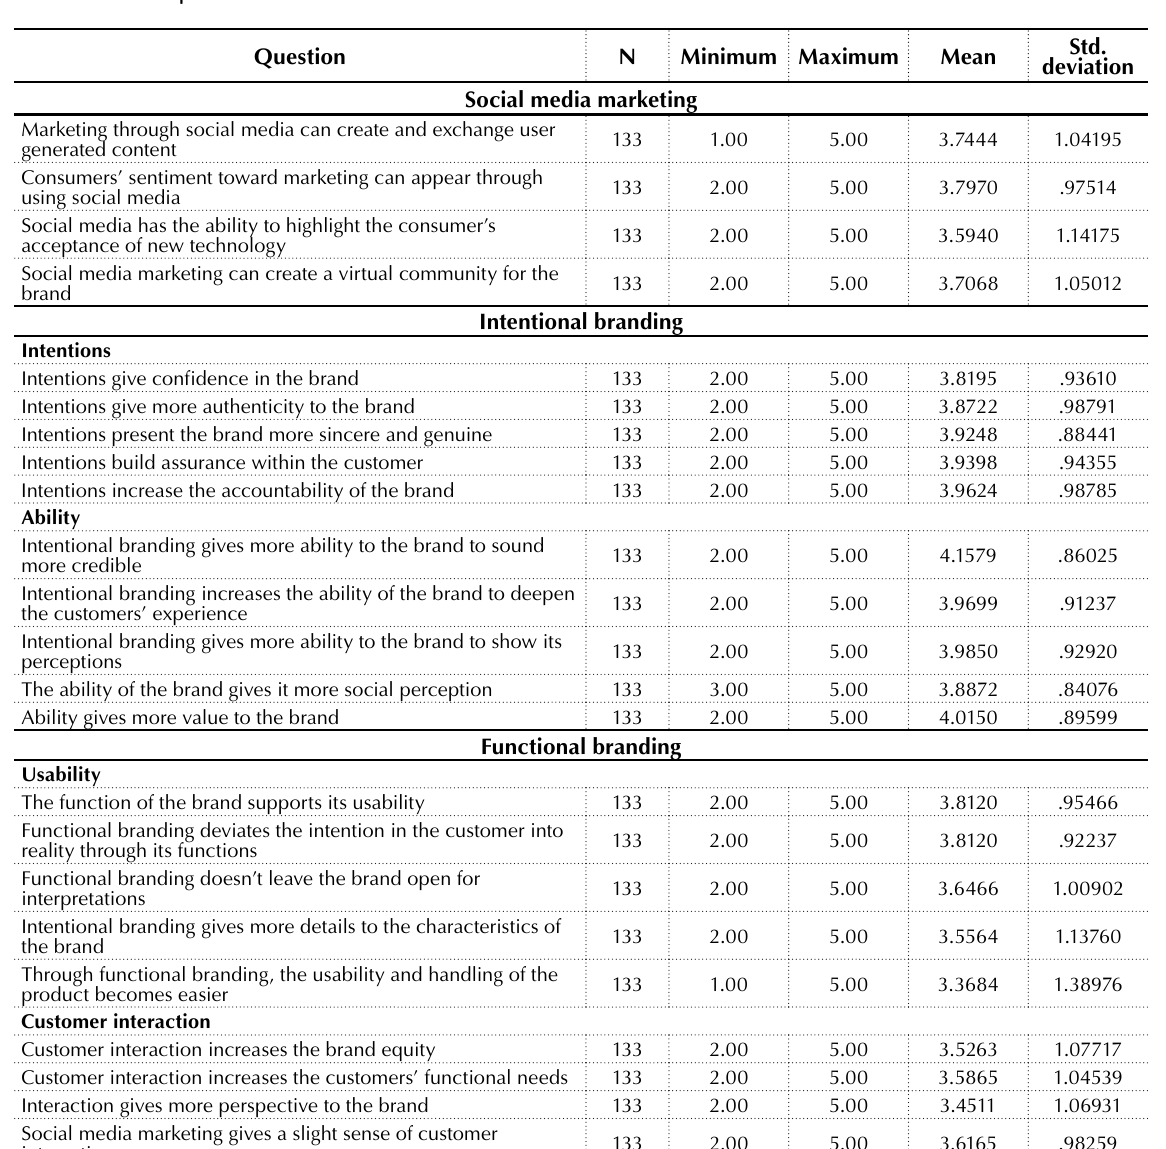
Table 4. Descriptive